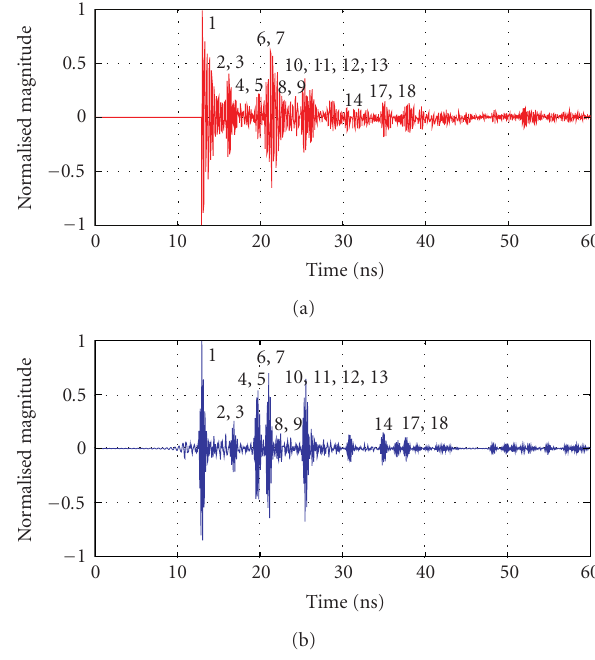
Figure 19: Comparison between simulation (b) and experiment (a). Echoes are corresponding in symmetric